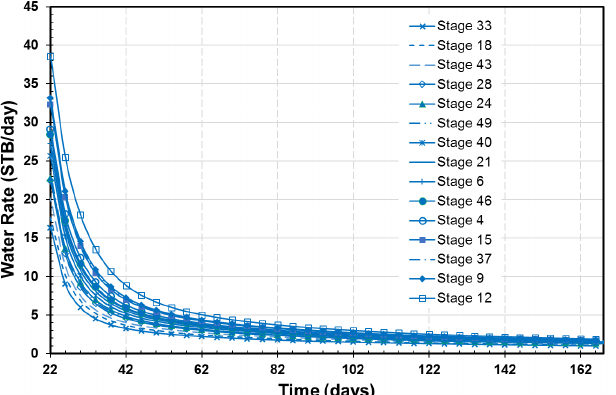
Figure 14. Stage-by-stage water production rate forecast for the 15 stages in Tables 5 and 6. The legend is arranged to correspond with the well performance ranking. Stage 12 has the greatest water production, while Stages 18 and 33 have the